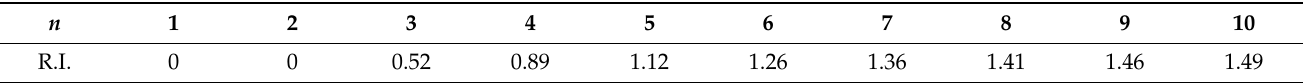
Table 8. Average random consistency index, R.I